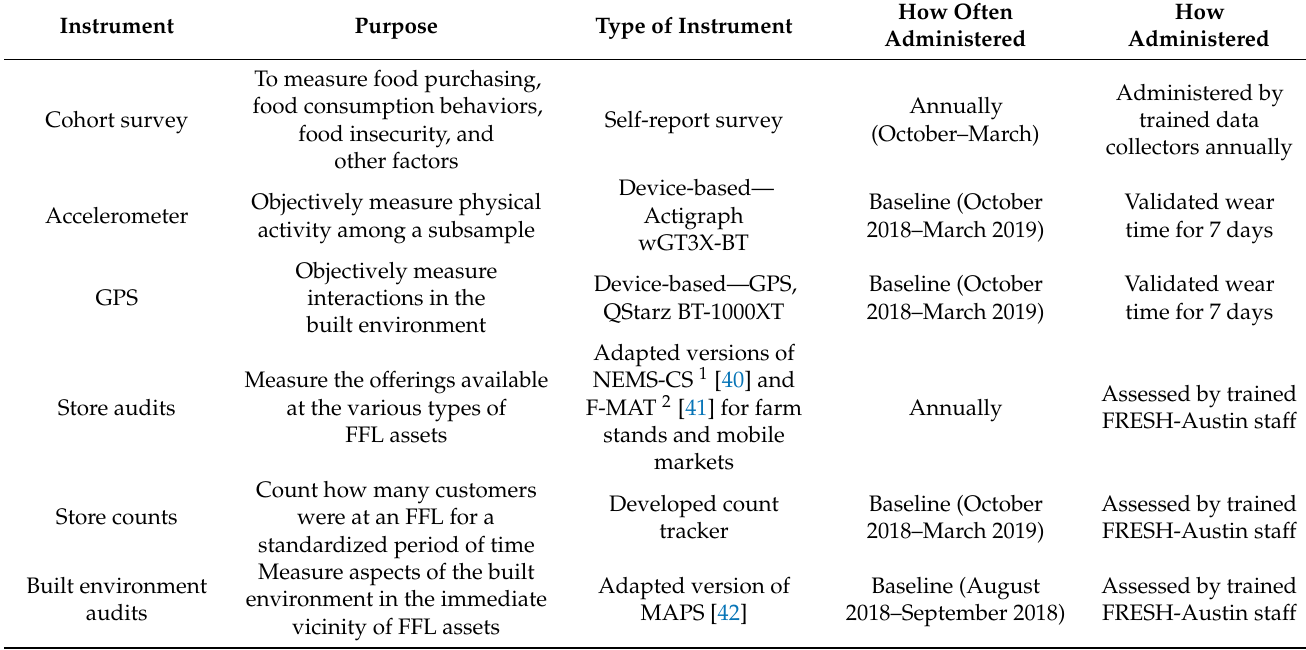
Table 1. Table of the measures included in the FRESH-Austin